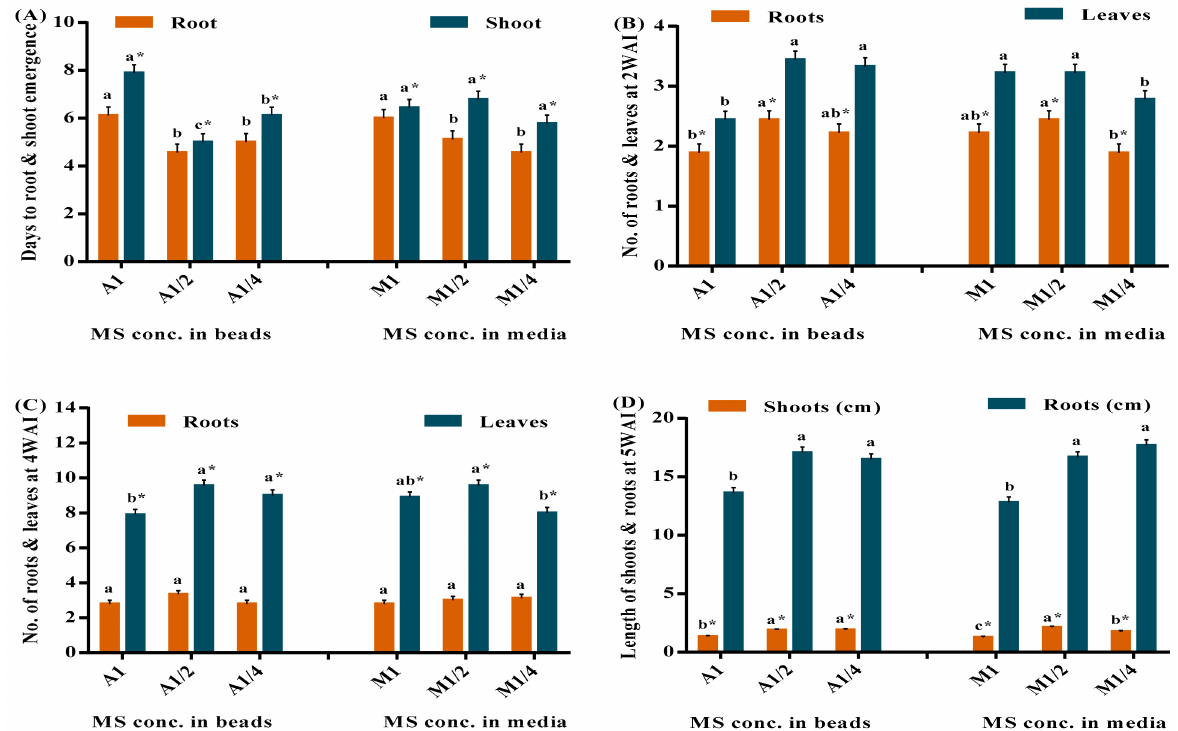
Figure 3. Effect of MS salts concentration on encapsulated vegetable sweet potato ( Ipomoea batatas L.) nodes, i.e., number of days to root and shoot production ( A ), number of roots and leaves at two weeks after inoculation into MS medium ( B ), number of roots and leaves at four weeks after inoculation into MS medium ( C ), and length of shoot and roots at four weeks after inoculation into MS medium ( D ). Full MS salts in the capsule (A1), 1 / 2 MS in the capsule (A1/2), 1 / 4 MS in the capsule (A1/4). Full MS salts in the growth media (M1), 1 / 2 MS salts in the growth media (M1/2), 1 / 4 MS salts in the growth media (M1/4). (*) indicate a significant interaction between the evaluated parameter at 5% probability levels. Means with a different letter (s) within the bars differ significantly at a 5% probability level using LSD.